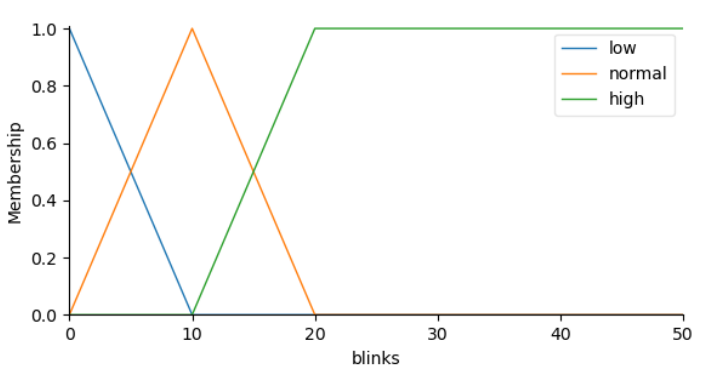
Figure 9. Fuzzy sets and membership functions of variable “blinks”.